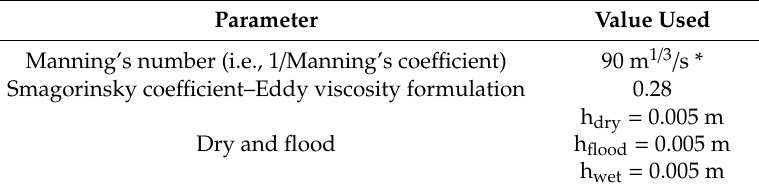
Figure 4. Hydrodynamic (HD) model calibration: comparison between model simulated and measured tidal level. ( a ) Haimen; ( b ) Langjishan. Table 1. Details of the variables used as inputs in HD module.